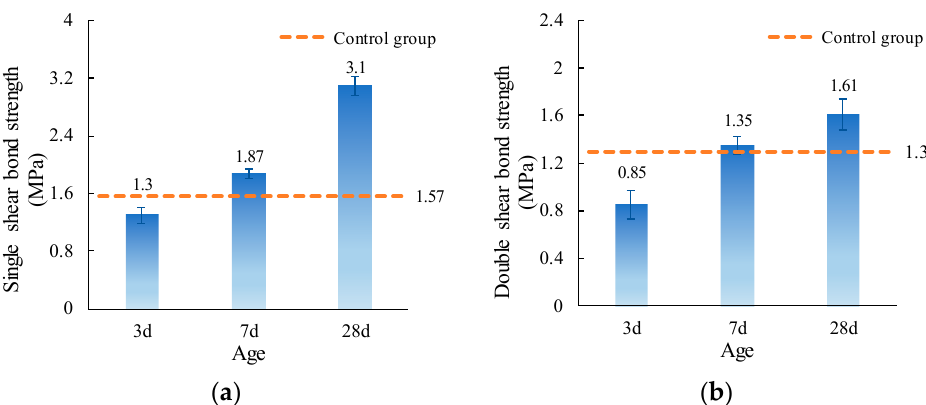
Figure 10. ( a ) Single shear bond strength and ( b ) double shear bond strength of specimens with varying fiber volume fraction ( V f ).